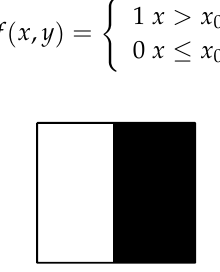
Figure 6. Ideal knife-edge area.